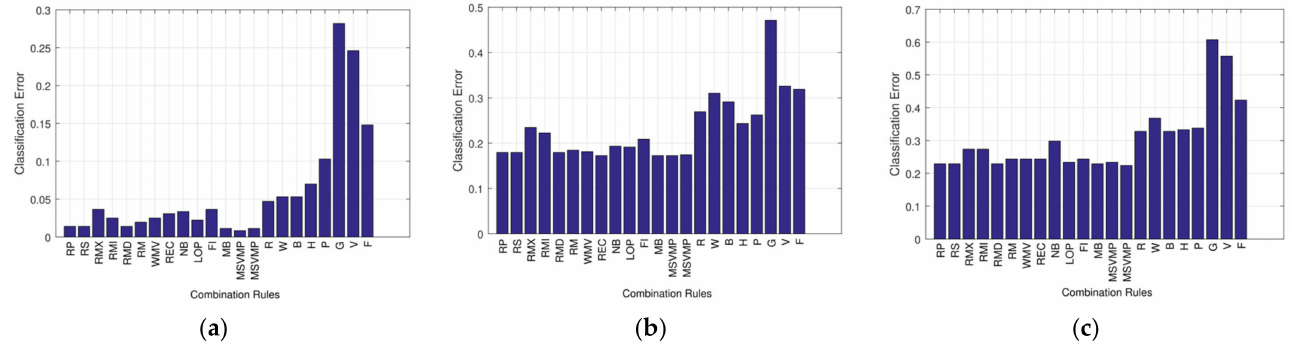
Figure 4. Classification error of the best schemes for each combination rule and individual schemes: ( a ) CK+ data set; ( b ) BU-3DFE data set; ( c ) JAFFE data